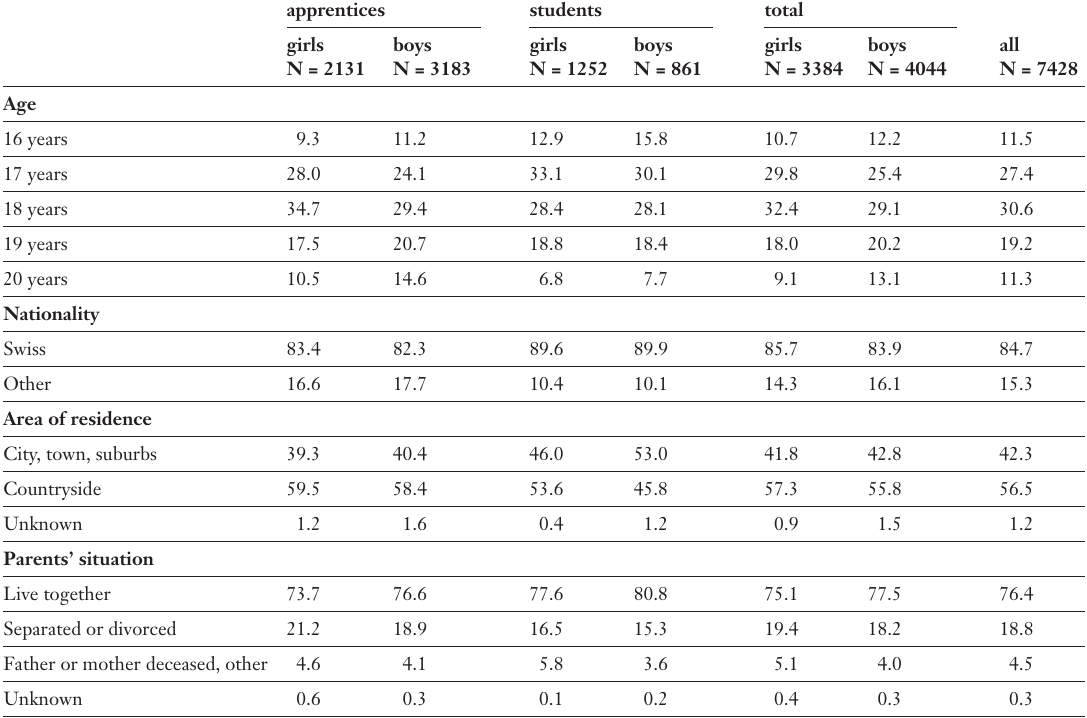
Table 1 SMASH 2002: main socio-demographic characteristics of the sample.